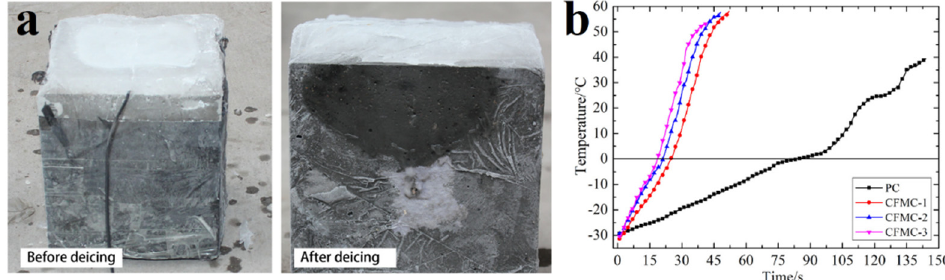
Figure 18. ( a ) Photographs of ice on the concrete surface before and after absorption of microwaves; ( b ) the heating rate of CMFC of different fibers concentrations compared to pure concrete. Reprinted with permission from [101].